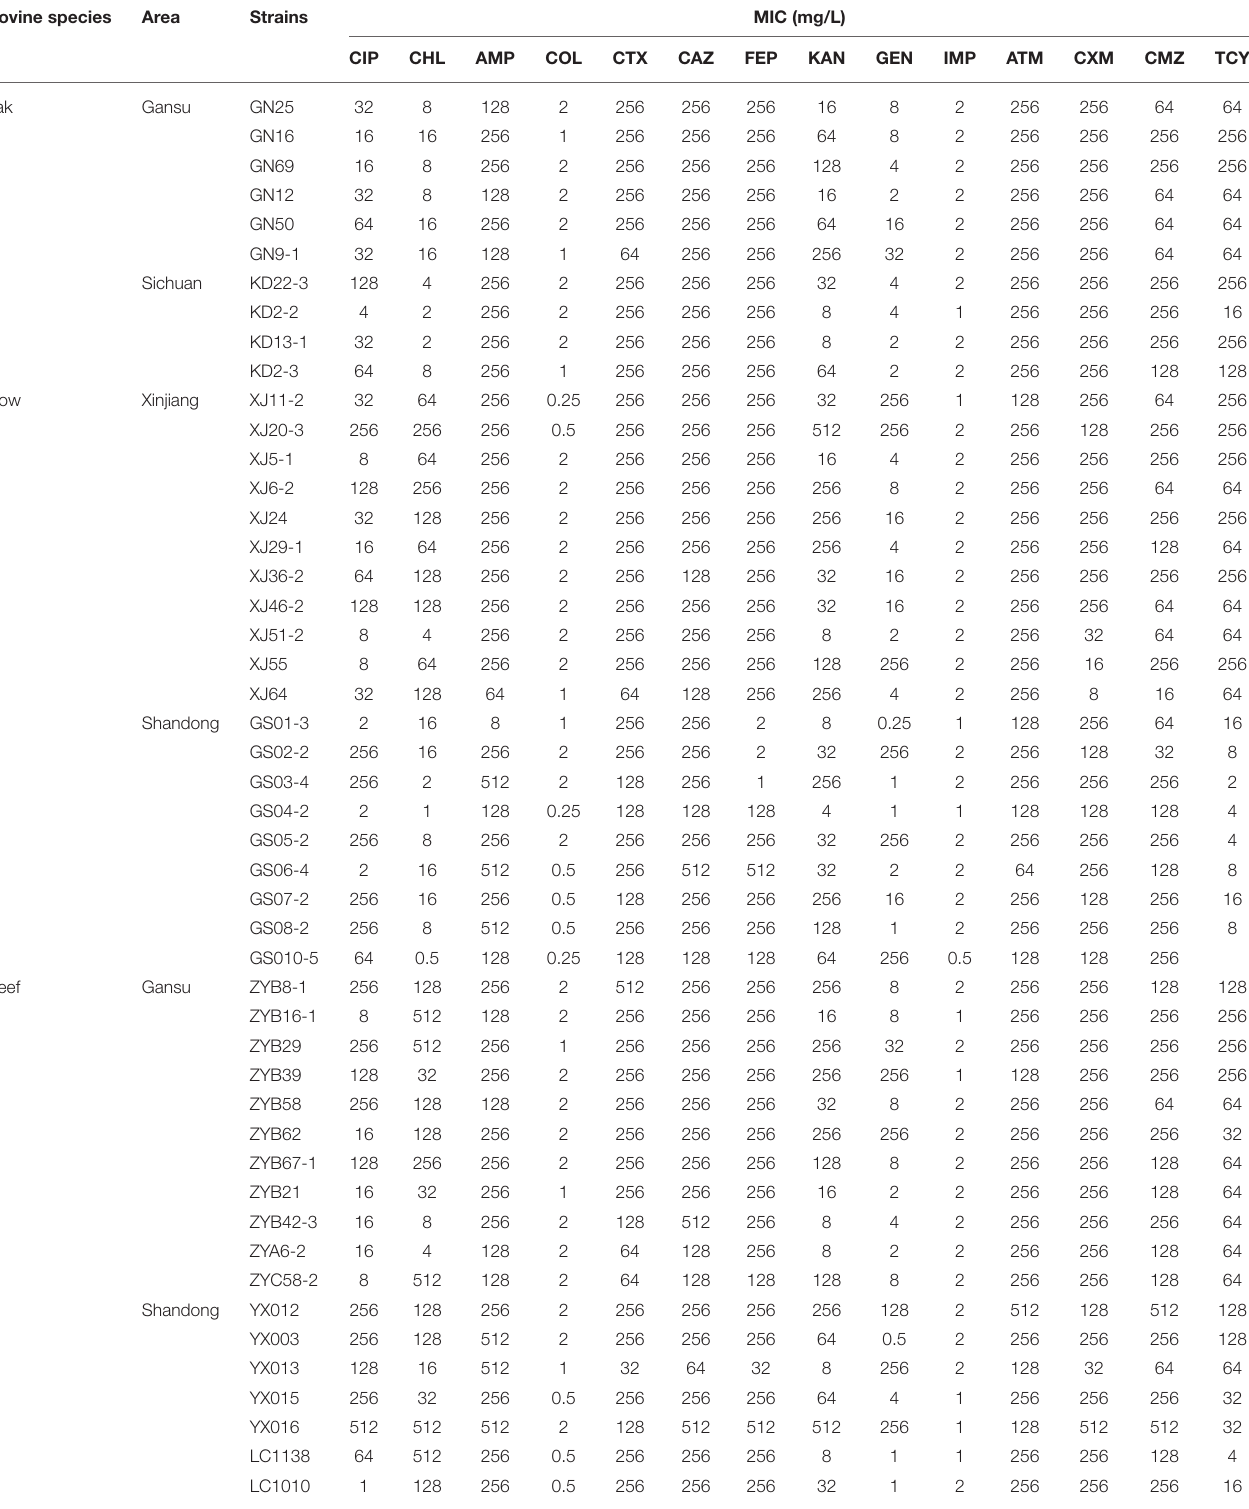
TABLE 2 | MIC of selected E.coli isolates. Bovine